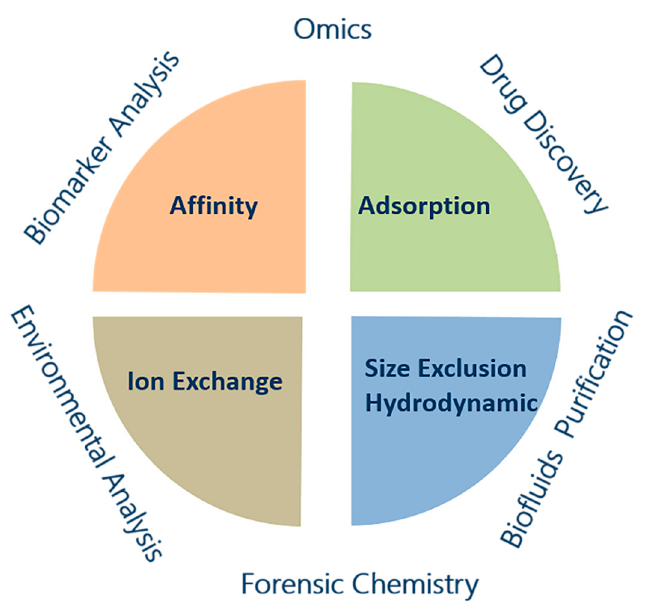
Figure 1. The mechanisms of microfluidics-based liquid chromatography (LC) and their applica-